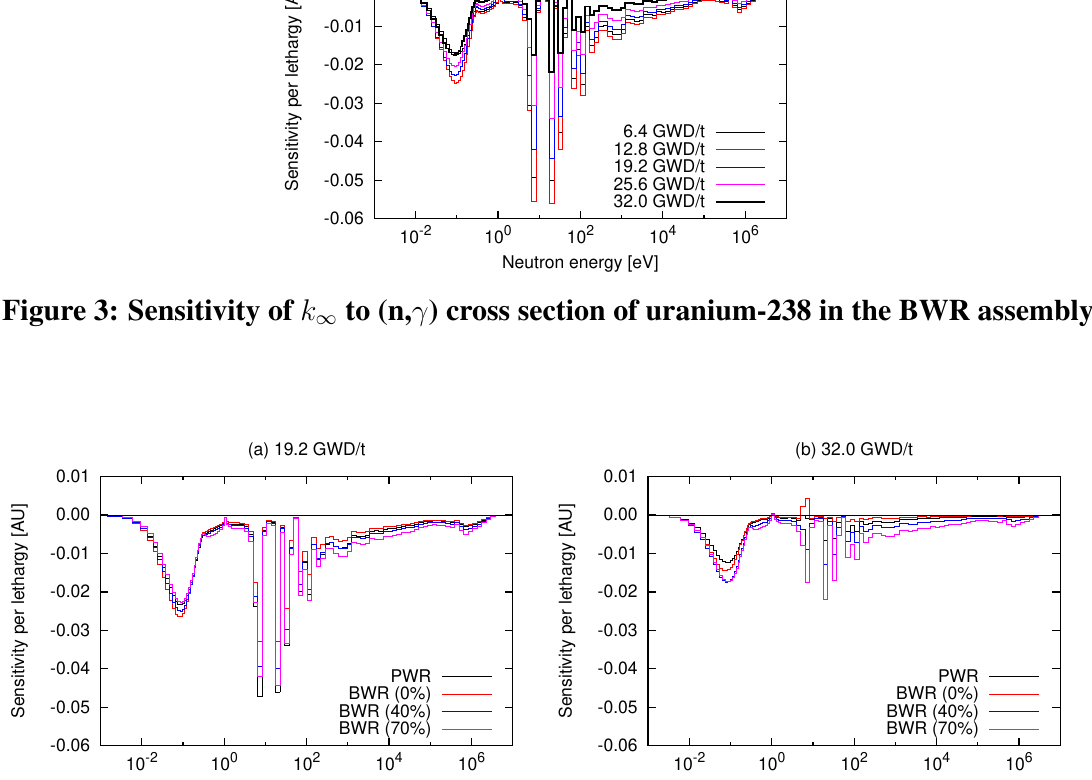
to (n, γ ) cross section of uranium-238 in the BWR and PWR ∞